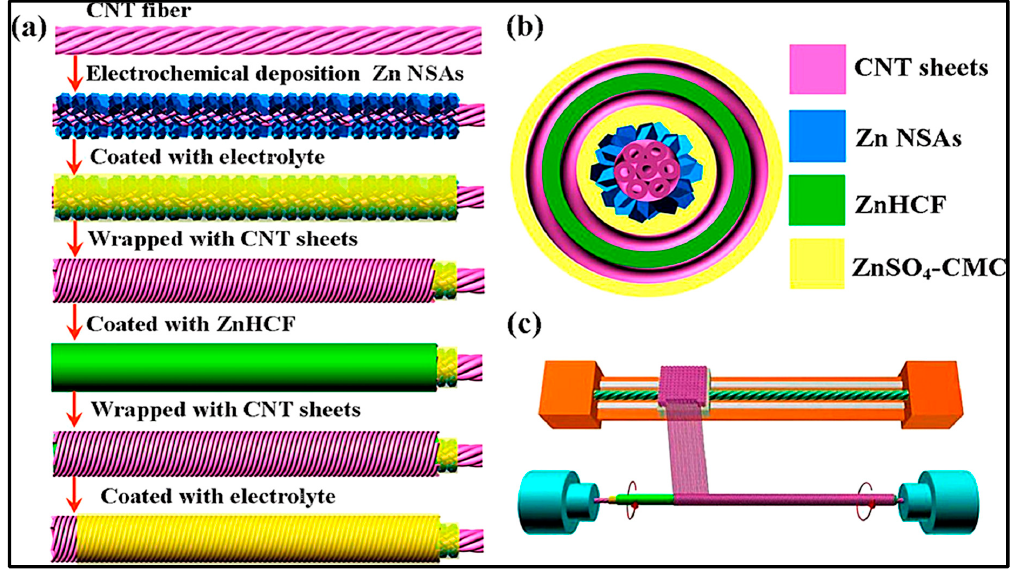
Figure 18. ( a ) Schematic illustrations showing the fabrication process of the coaxial aqueous rechargeable ZIB. ( b ) Schematic illustration of the cross-section view of the coaxial aqueous rechargeable ZIB. ( c ) Wrapping CNTSs around the modified CNTF. Reproduced with permission from [315]. Copyright 2019 The American Chemical Society.